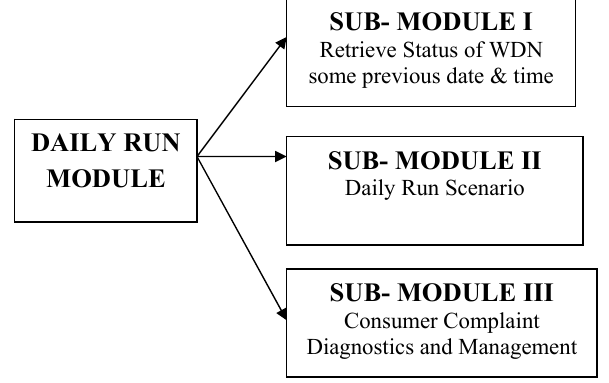
Fig. 11. New Project form of ES